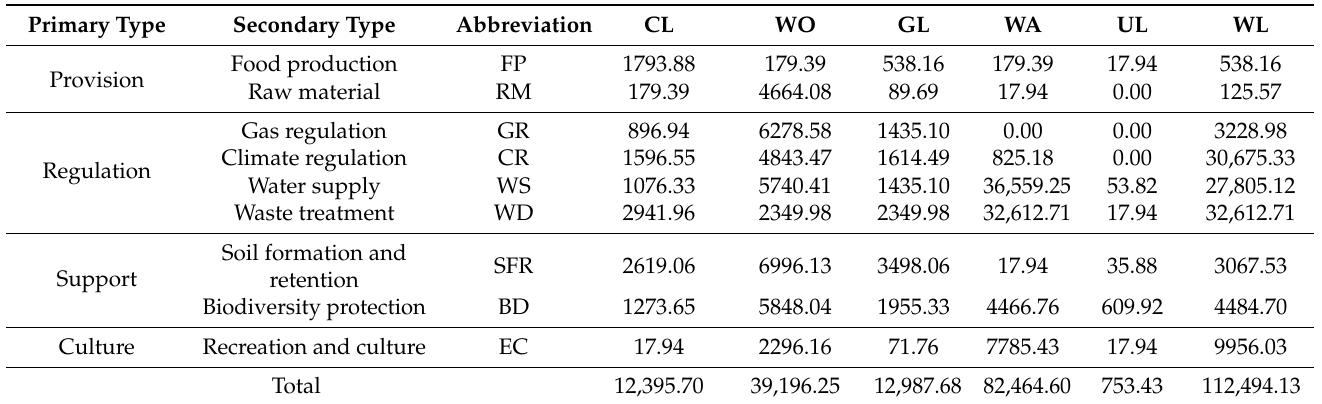
Table 1. ESVs per unit area by land use type in the Dongting Lake (Unit: Yuan/hm 2